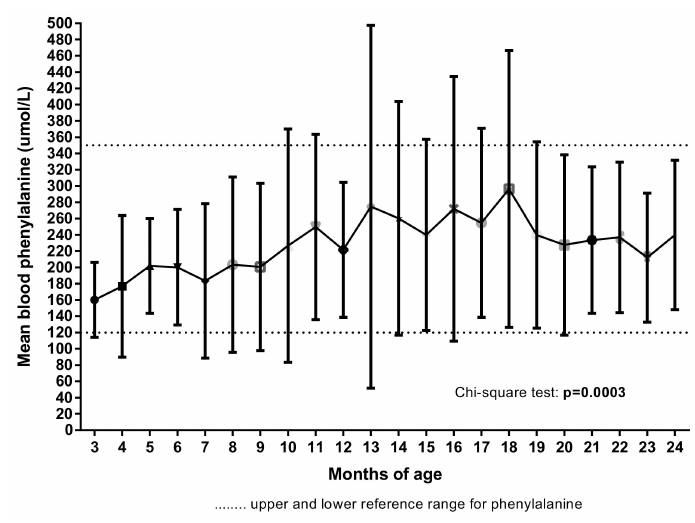
Figure 6. Mean child blood phenylalanine levels by